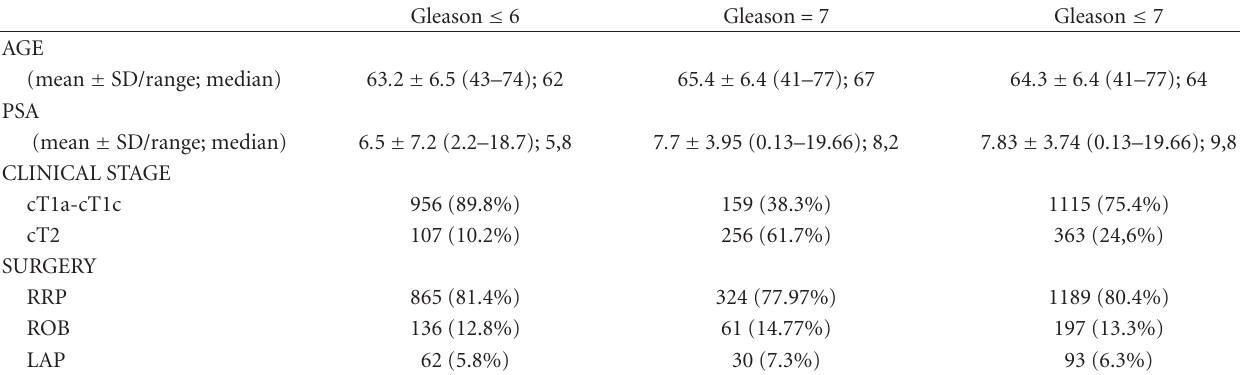
Table 2: Clinical data and preoperative characteristics of the three groups of